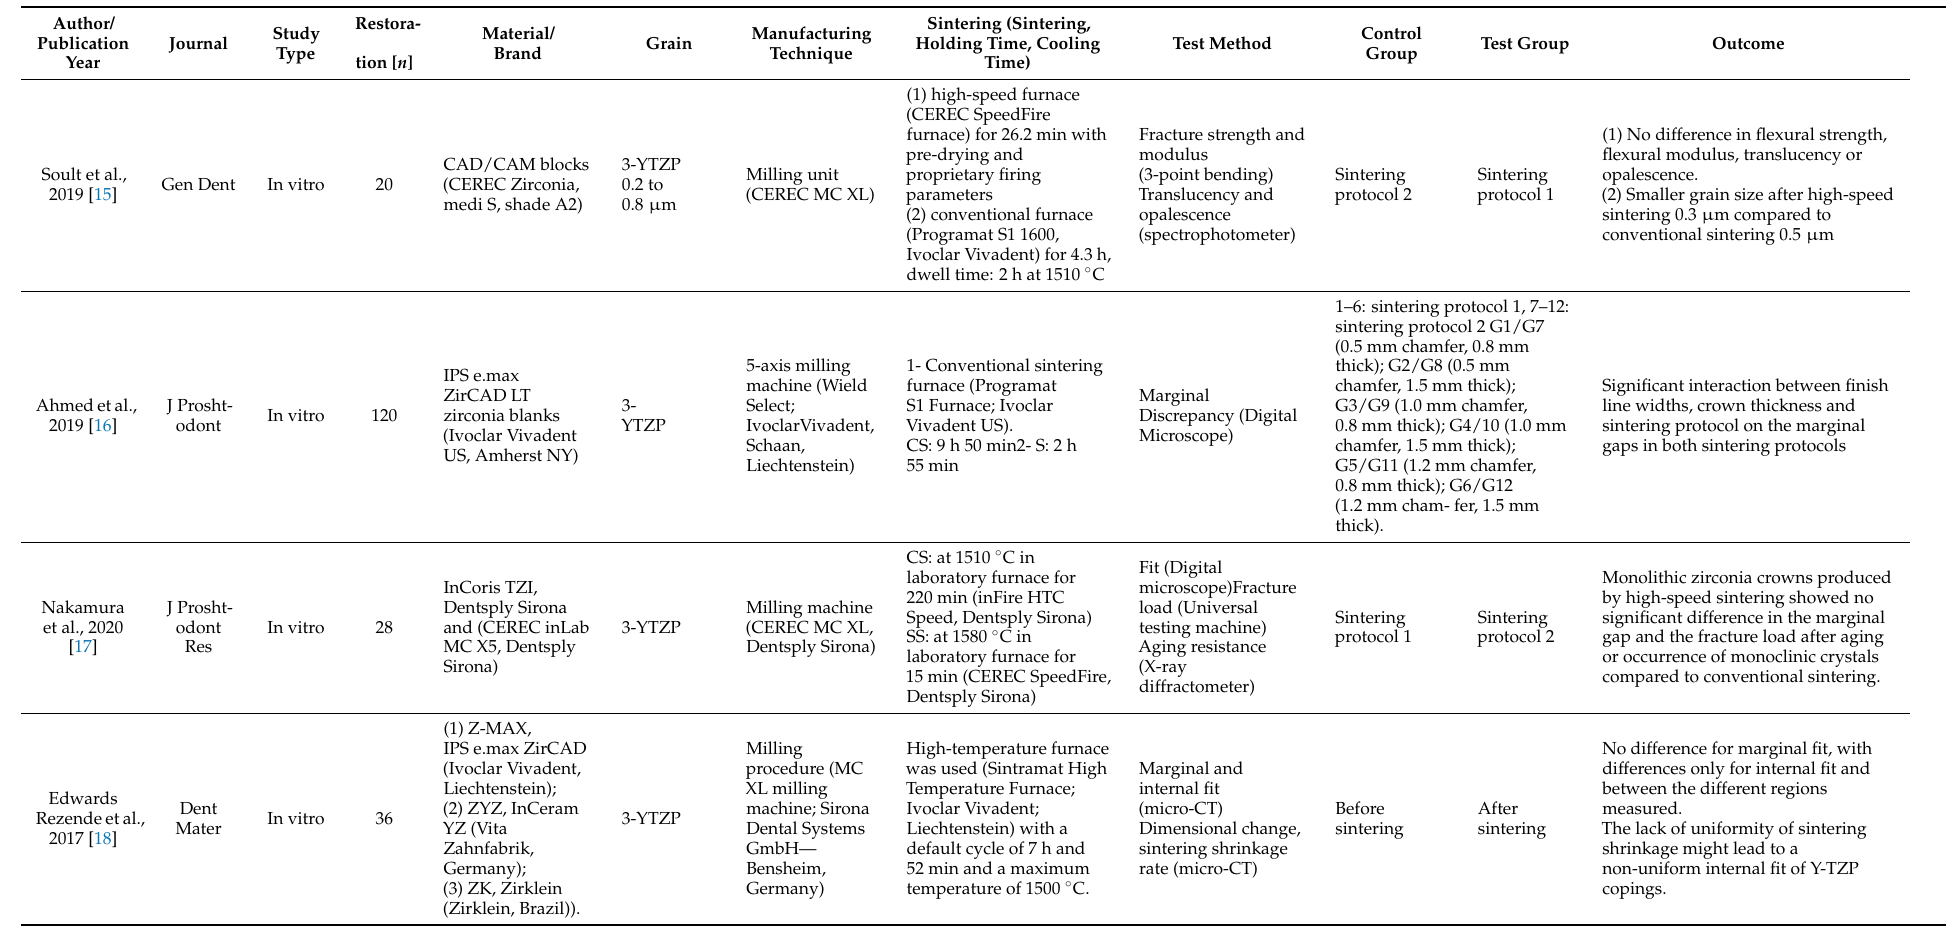
Table 2. Characteristics of included studies. CS: Conventional sintering; S: Speed sintering SS: Super Speed